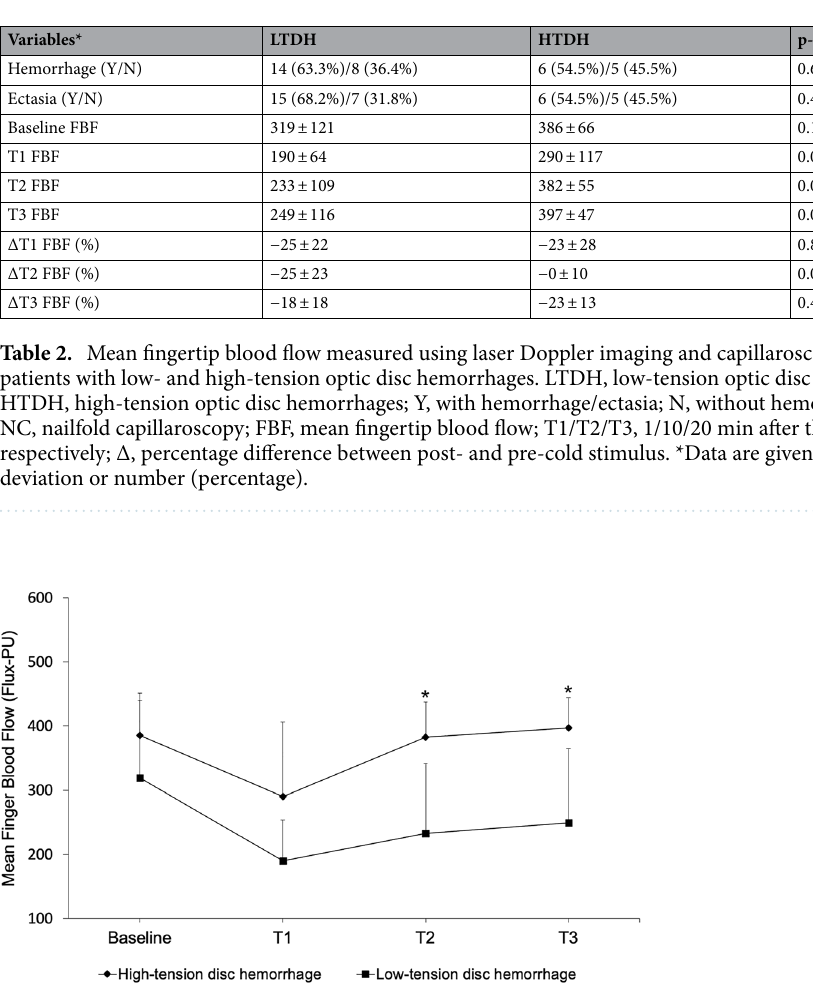
Figure 3. Mean finger blood flow estimated through laser Doppler imaging at baseline and the cold stimulus (T1, 1 min; T2, 10 min; T3, 20